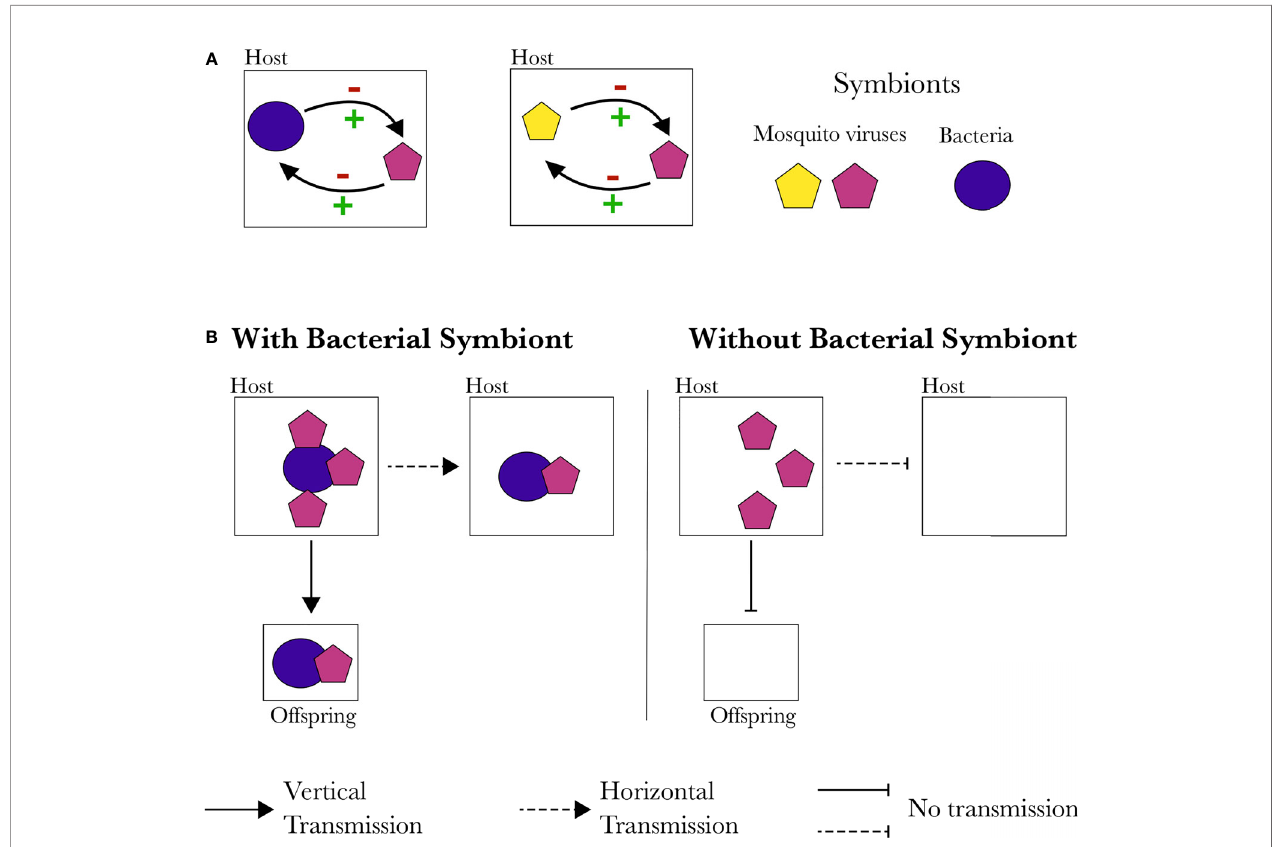
FIGURE 3 | Possible interactions between mosquito endosymbionts. (A) Gene products of a symbiont may affect other symbionts. This effect can either be direct or indirect (e.g. through modulation of the host cellular environment or immune responses) resulting in an increase or decrease in entry or replication of another symbiont. (B) Direct protein interactions can increase or block other symbionts horizontal or vertical transmission or cell